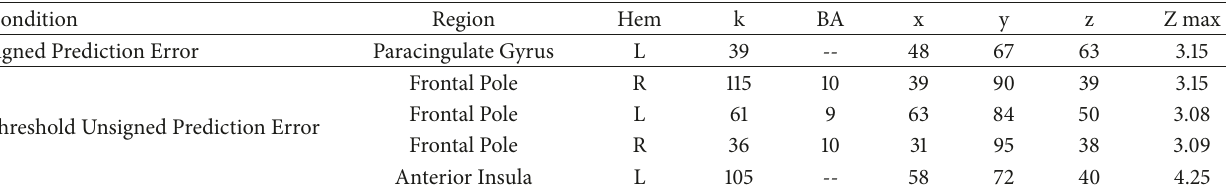
Table 2: Frontostriatal functional activation clusters showing ASD > TDC differences in voxel-wise analyses. No regions showed ASD < TDC differences (see text for details).